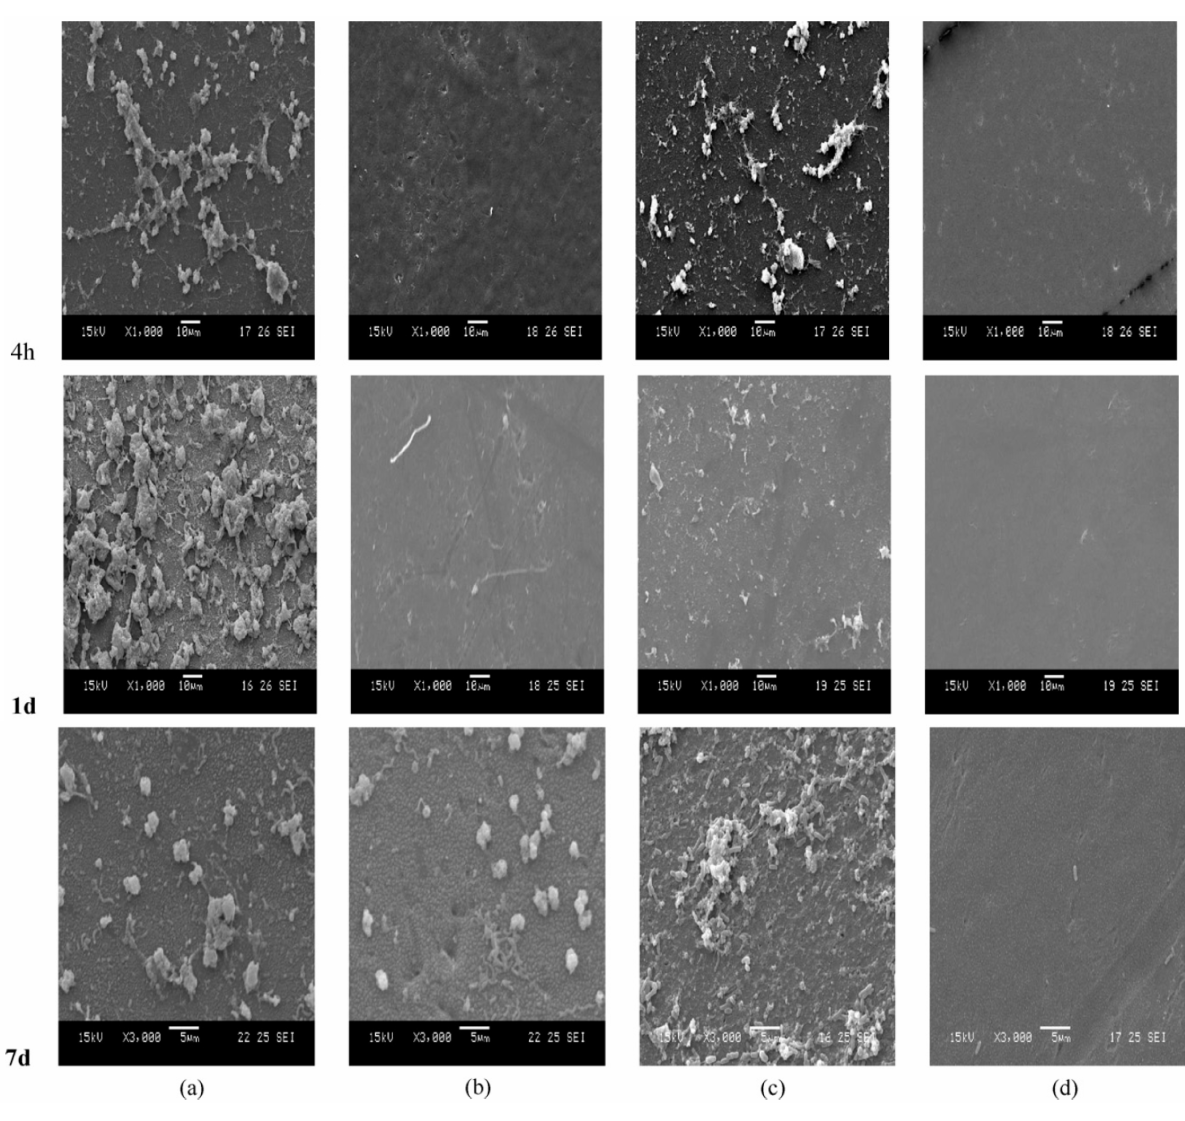
Figure 5. Bacterial adhesion and growth on the ( a ) chitosan/cellulose acetate (CS/CA); ( b ) chitosan/cellulose acetate-heparin (CS/CA-H); ( c ) chitosan/cellulose acetate-silver (CS/CA-Ag) and ( d ) chitosan/cellulose acetate-heparin/silver (CS/CA-H/Ag) membranes after immersion in an activated sludge bioreactor for a period of up to 7 days. Reproduced with permission from Reference [347]. Copyright 2010